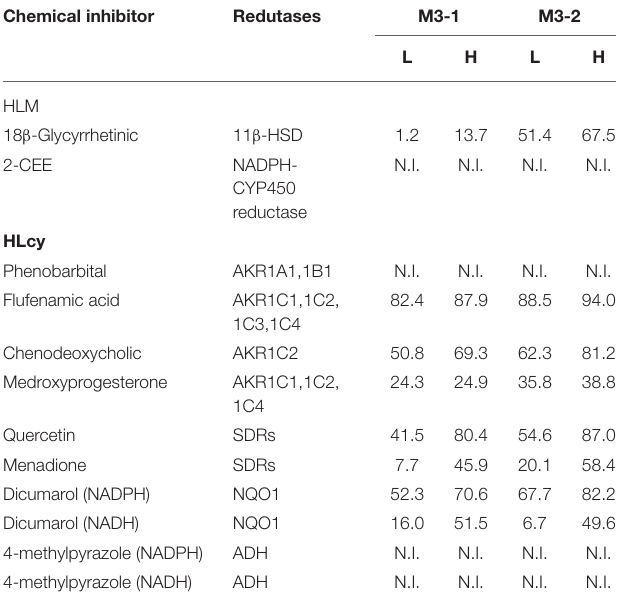
TABLE 4 | Percentage of inhibition of the formation of M3-1 and M3-2 by chemical inhibitors in HLM and HLcy. Chemical inhibitor Redutases M3-1 M3-2 L H L H